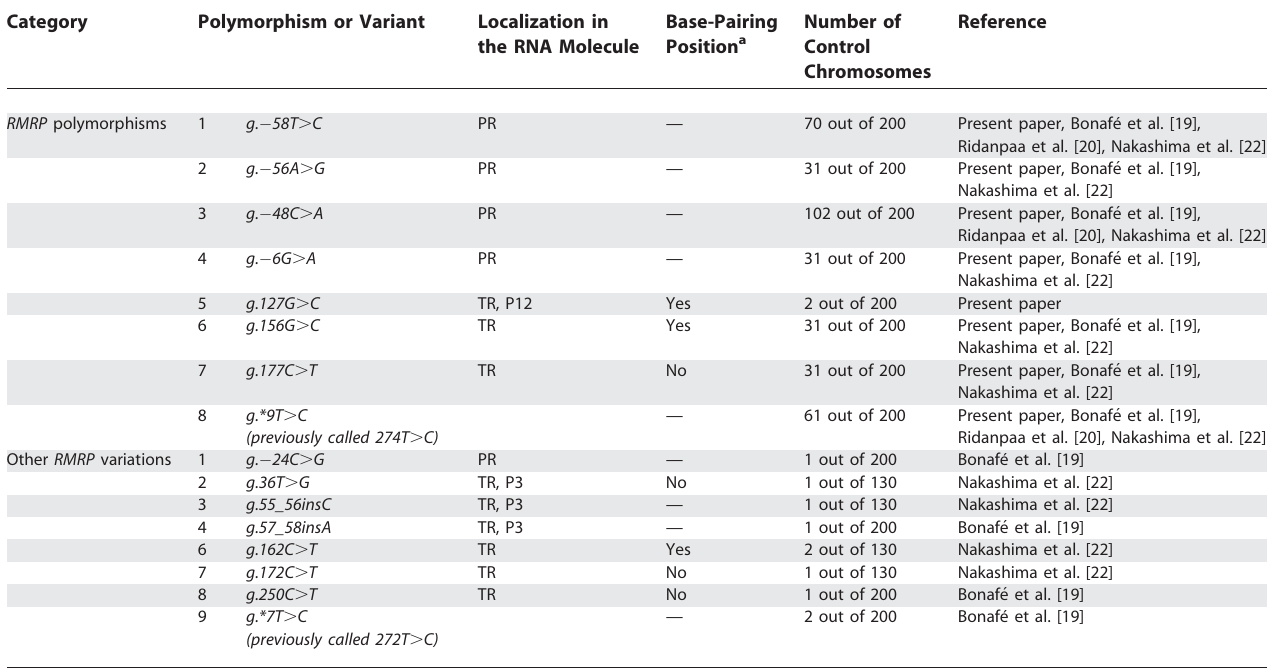
Table 3. RMRP Polymorphisms and Other Rare Variants Category